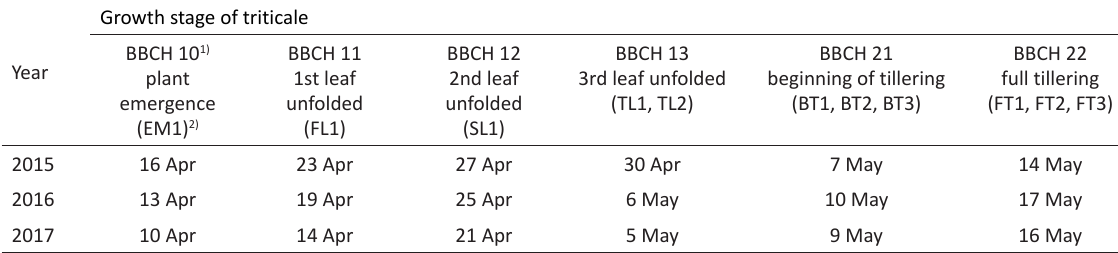
Table 2. Timing of weed harrowing in